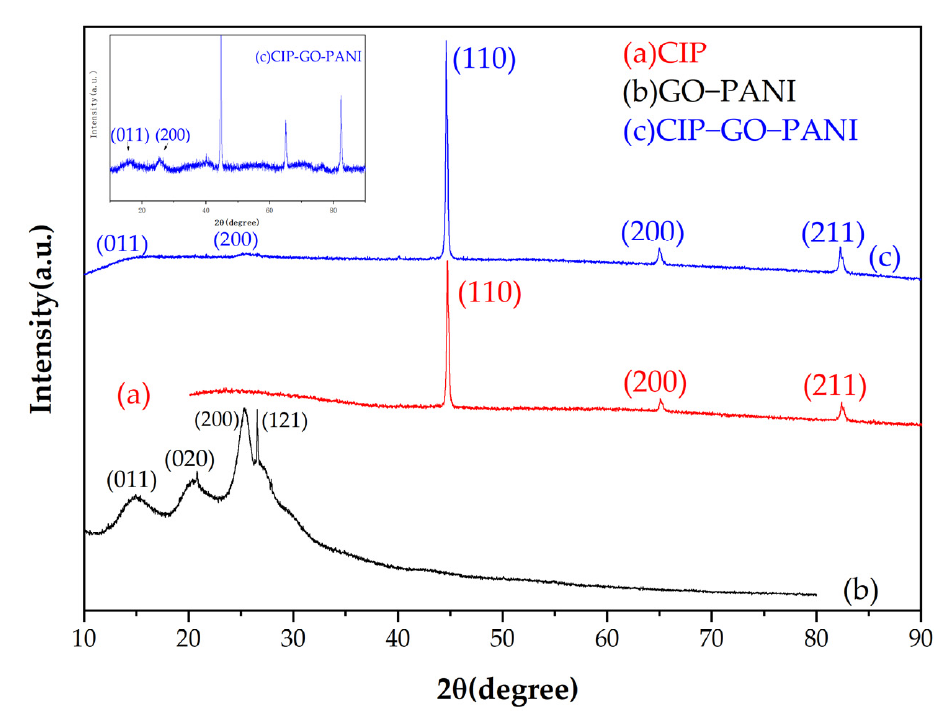
Figure 5. XRD images of ( a ) CIP, ( b ) GO-PANI and ( c ) CIP-GO-PANI. Figure 6 is the infrared spectrum of CIP-GO-PANI. For GO, the peak at 3602 cm − 1 is the stretching vibration peak of the O-H group in the C-OH in GO, the peak at 1740 cm − 1 is attributed to the C=O stretching vibration [23], and the peak at 1635 cm − 1 is the C=C stretching vibration peak of the sp 2 hybrid structure of GO. The peak at 1406 cm − 1 is caused vibration peak of the carboxyl group